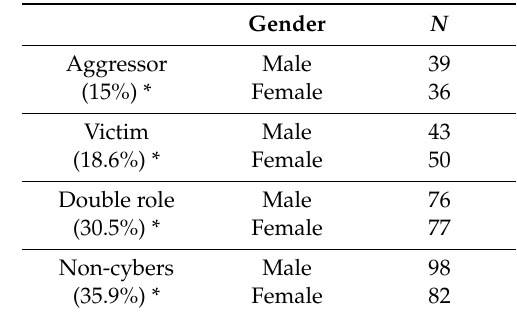
Table 1. Participants’ status (i.e., cyberbully, cyber victim, double role, or non-cyber) depending on gender and age ( N =